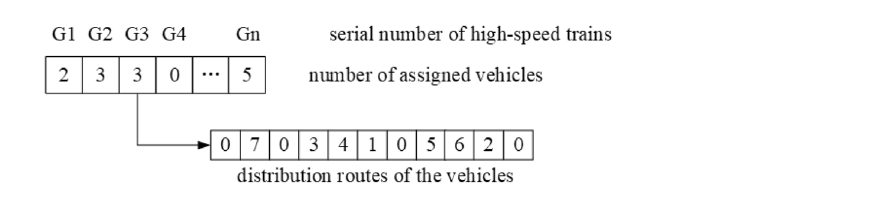
Figure 2. Schematic diagram of two-level coding structure.